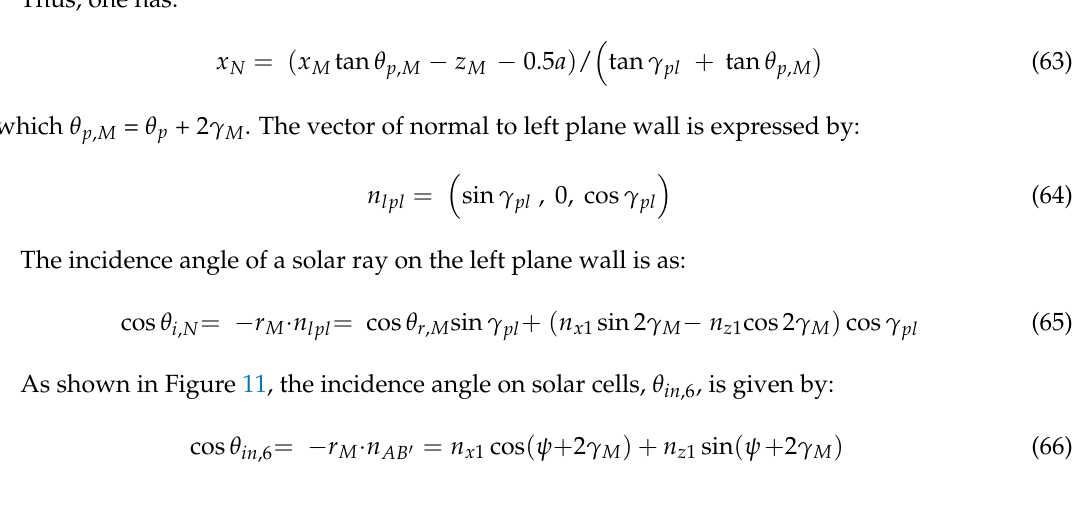
Figure 11. Way to solar cells for radiation incident on upper parabola wall at θ a < θ p < θ p , c 2